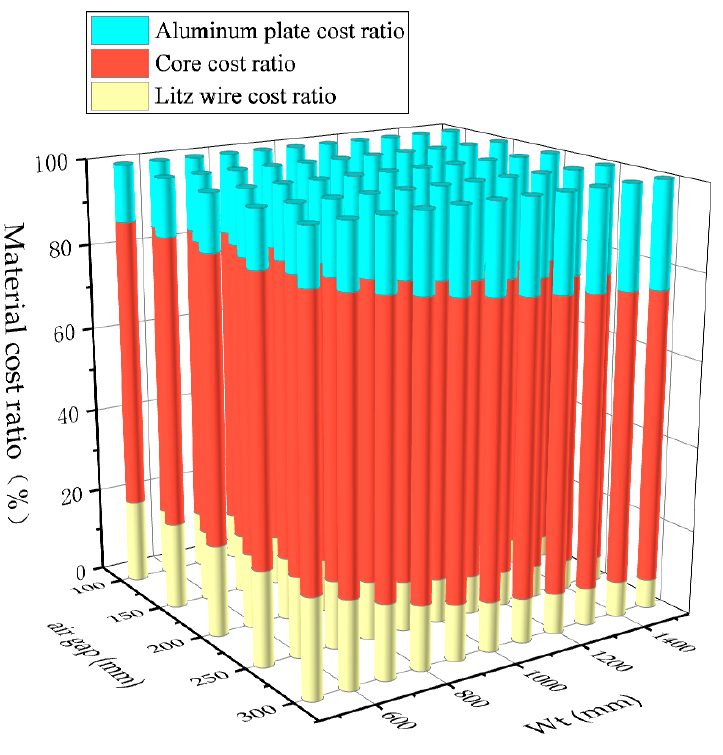
Figure 8. Various material cost percentages.